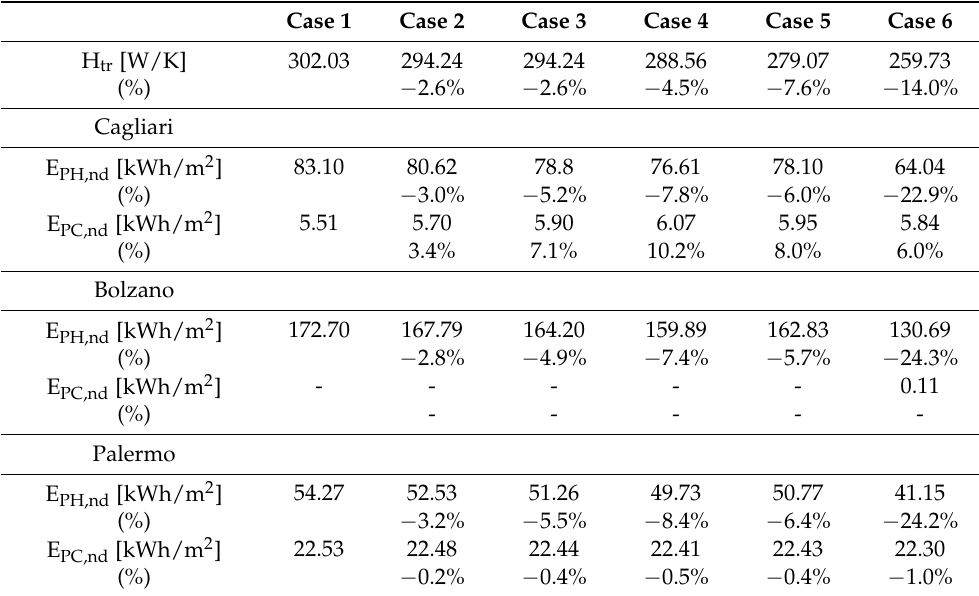
Table 6. Transmission heat loss coefficient and useful thermal energy requirements for different materials and reference climatic